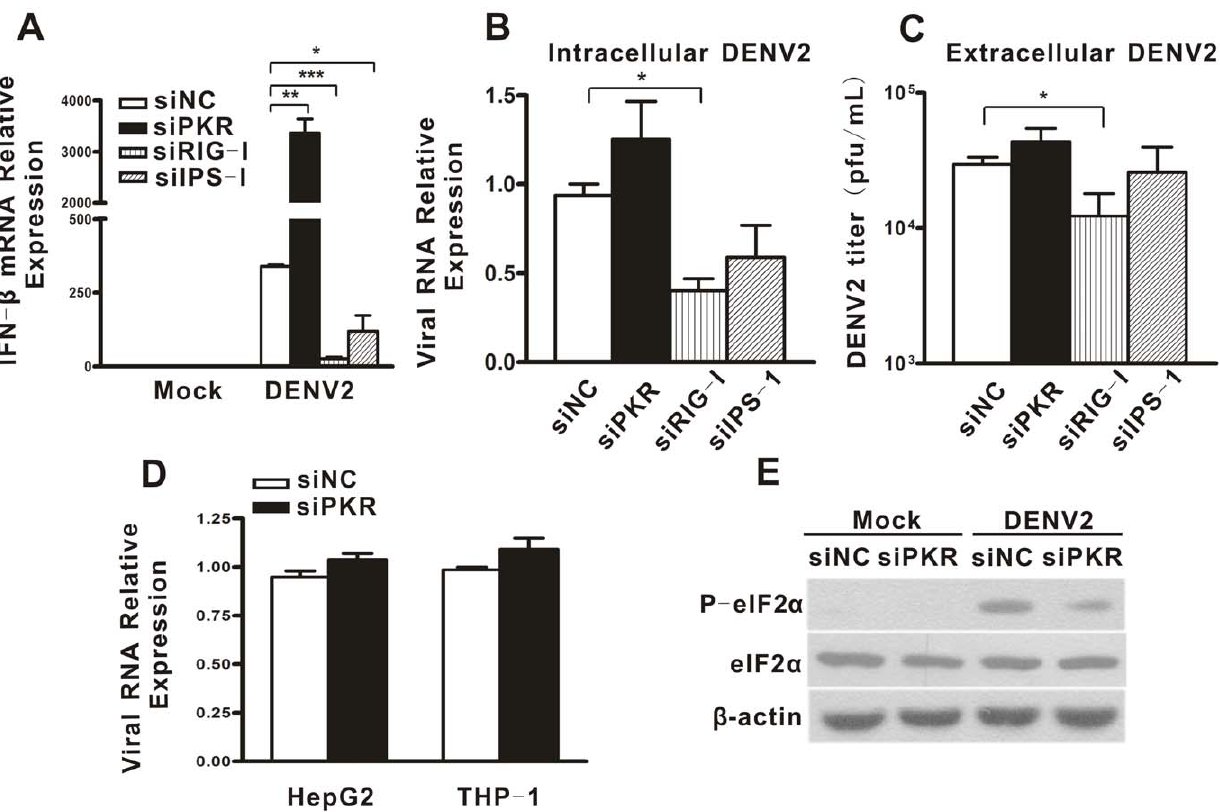
Figure 5. PKR depletion barely affected DENV2 replication in A549 cells. A549 cells were transfected with siNC, siPKR1, siRIG-I and siIPS-1, followed by DENV2 infection. Cells and culture supernatants were harvested for real-time PCR and viral titration respectively. Total cellular RNA was analyzed for IFN- b (A) or DENV2 RNA (B) level by real-time PCR and normalized to that of GAPDH in each sample. Virus yields were determined by TCID50 assay (C). DENV2 RNA levels in siNC- or siPKR-transfected HepG2 and THP-1 cells were measured by real-time PCR (D). Data are shown as mean 6 SEM at least three independent experiments. Phosphorylation form and total protein levels of eIF-2 a in DENV2-infected A549 cells were detected by Western blot (E). *p , 0.05,**p , 0.01, ***p ,